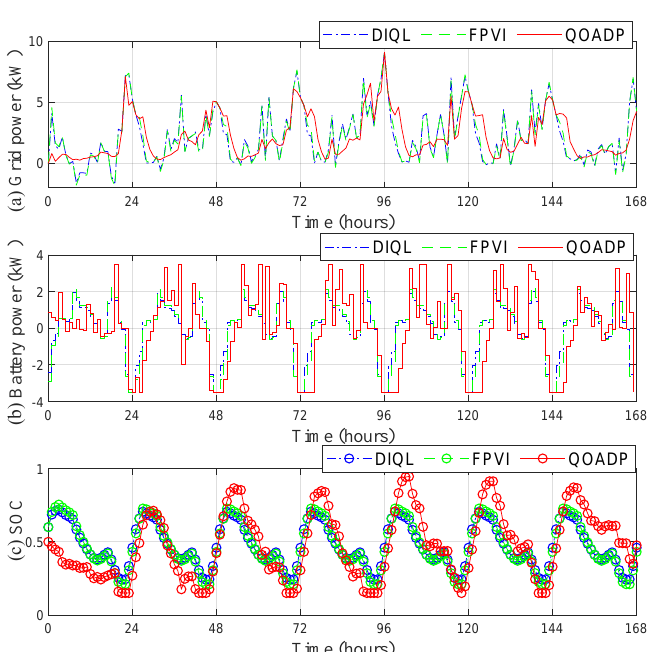
Figure 8. System state and control under load demand of high volatility: ( a ) Grid power; ( b ) Battery power; ( c ) SOC.